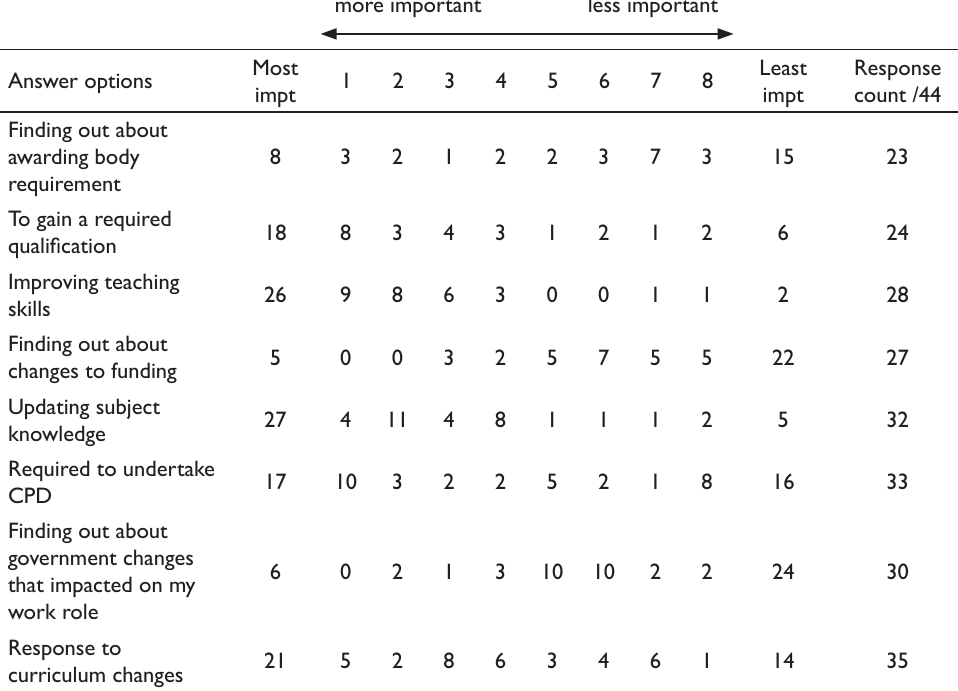
Table 1: Ranking of reasons for undertaking